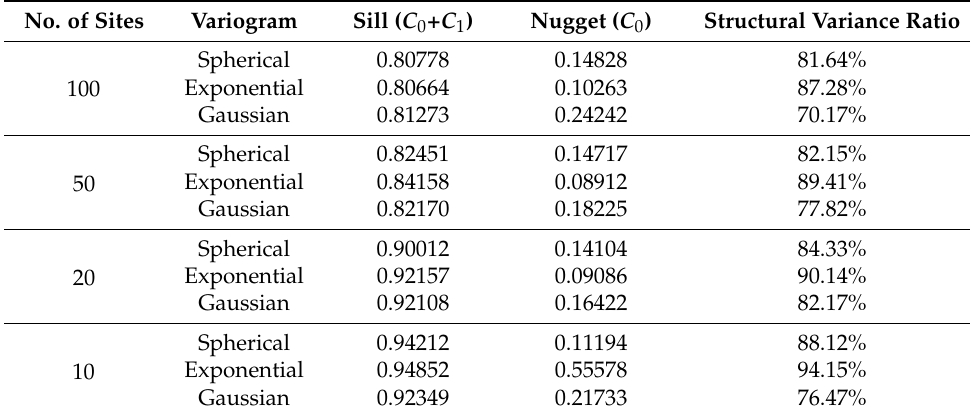
Table 3. Quantitative analysis results of three different variograms.